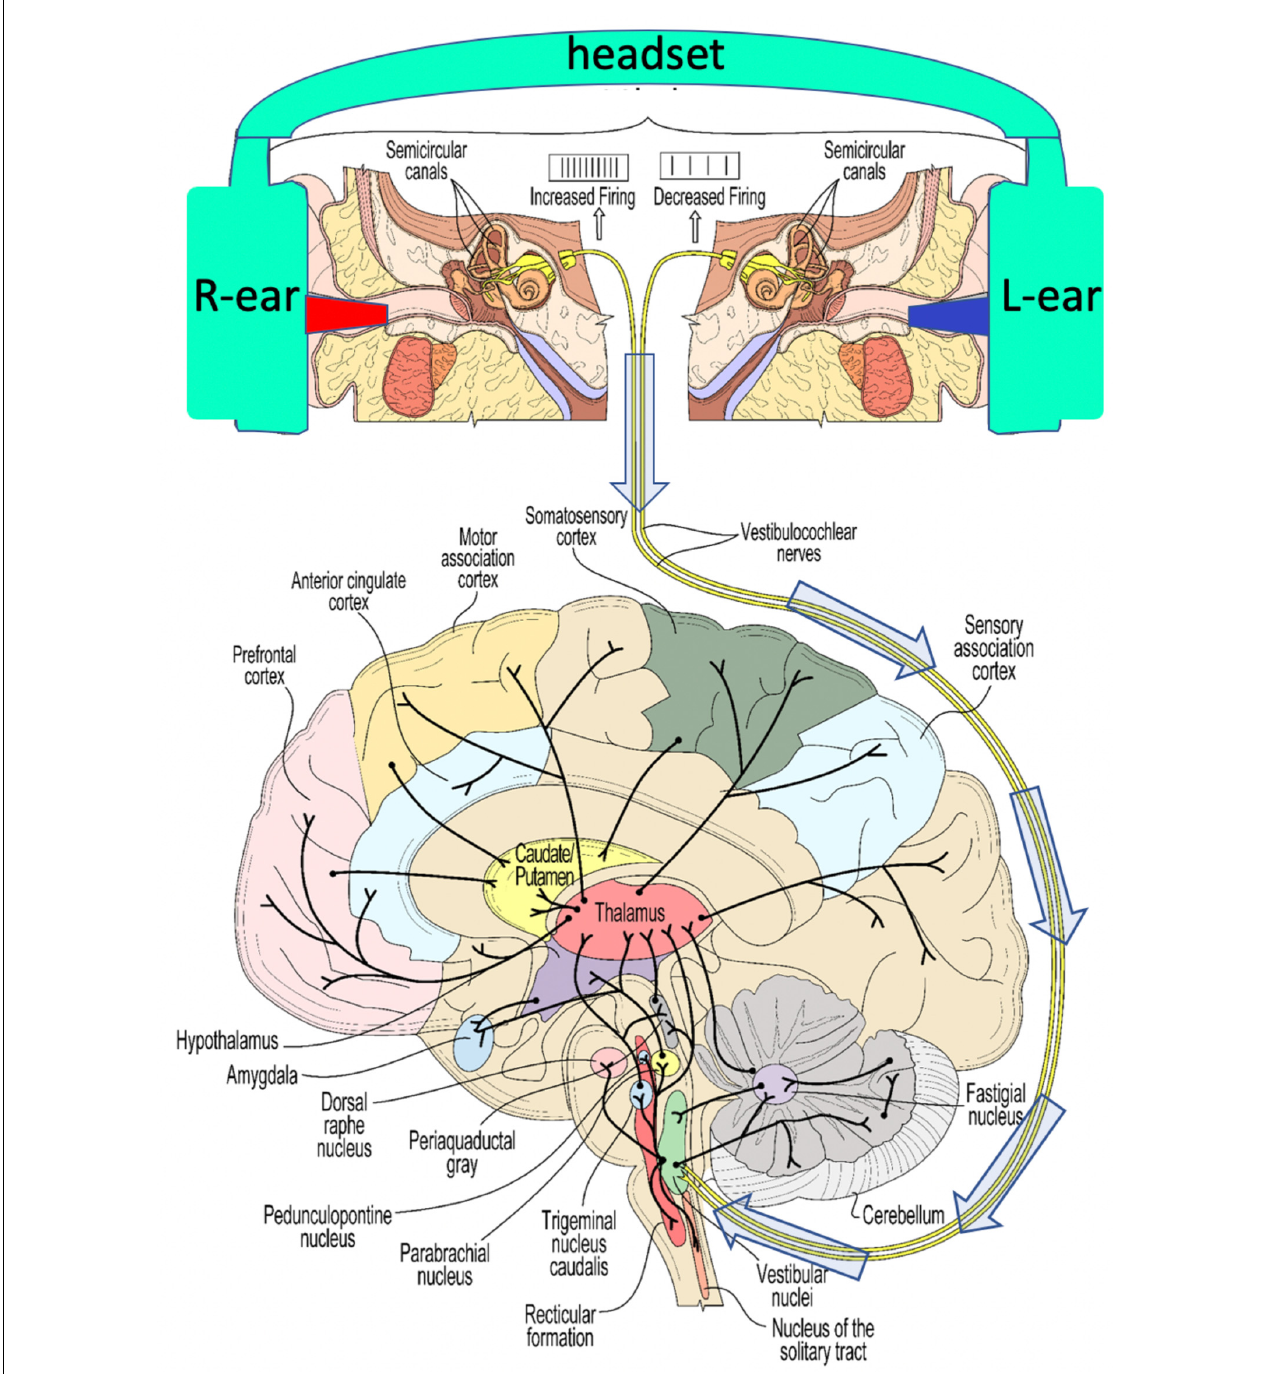
FIGURE 5 | A schematic view of some of the widespread connectivity of the vestibular system. The top panel illustrates the induction of caloric vestibular stimulation (CVS) using warm (red)/cool (blue) ear inserts that are a part of a vestibular neuromodulation (VNM) device described below (see Figure 8 for example, thermal waveforms). The 8th cranial nerve conveys vestibular stimulation (arrows) to the vestibular nuclei in the brainstem.